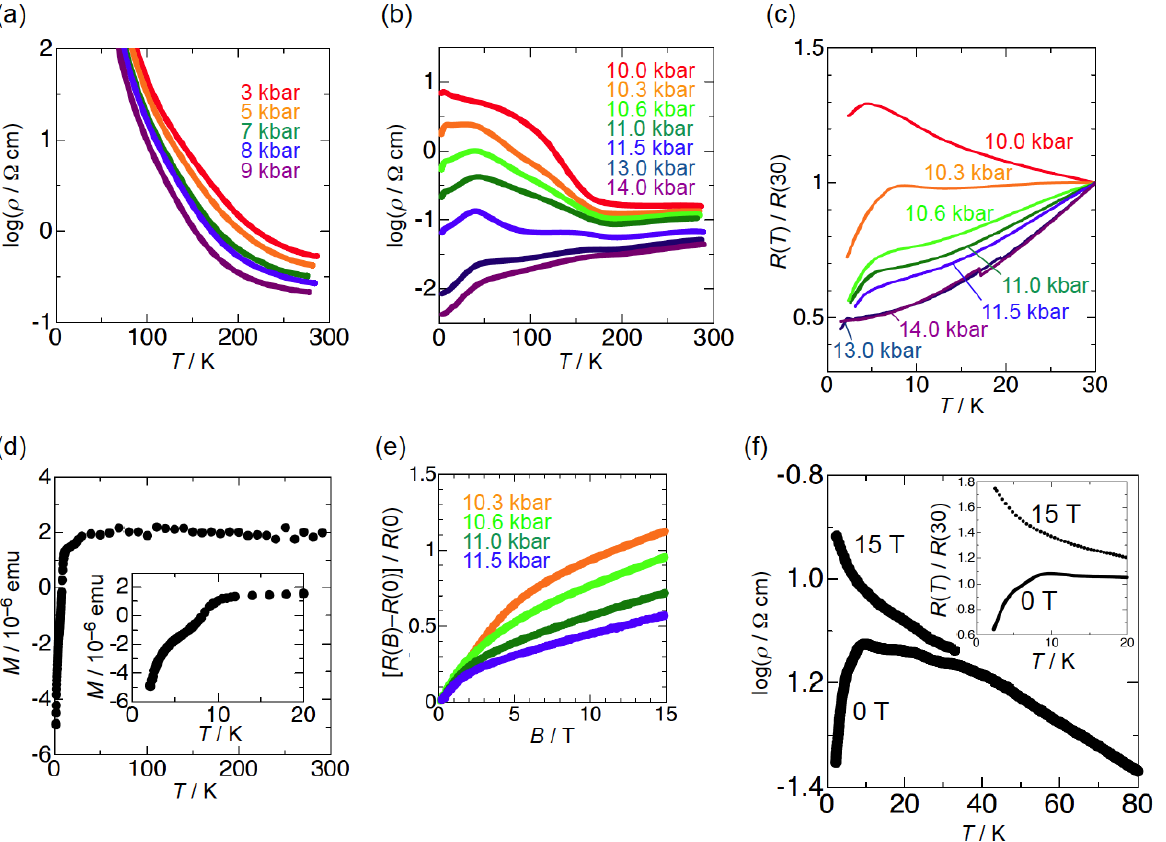
Figure 5. Temperature dependence of the resistivity of β-(BDA-TTP) pressures of up to 9 kbar and ( b ) at different pressures 10.0, 10.3, 10.6, 11.0, 11.5, 13.0 and 14.0 kbar. ( c ) Temperature dependence of the relative resistance of β-(BAD-TTP) 30 K under pressures of 10.0 to 14.0 kbar. ( d ) Temperature dependence of the magnetization of β-(BDA-TTP) shows the magnetization below 20 K. ( e ) Magnetoresistance (MR) of β-(BDA-TTP) under different pressures 10.3, 10.6, 11.0 and 11.5 kbar at 1.6 K. ( f ) Magnetic field dependence of the resistance drop in β-(BDA-TTP) temperature dependence of the relative resistance below 20 K at 0 and 15 T (Reprinted with permission from reference 20, The Royal Society of